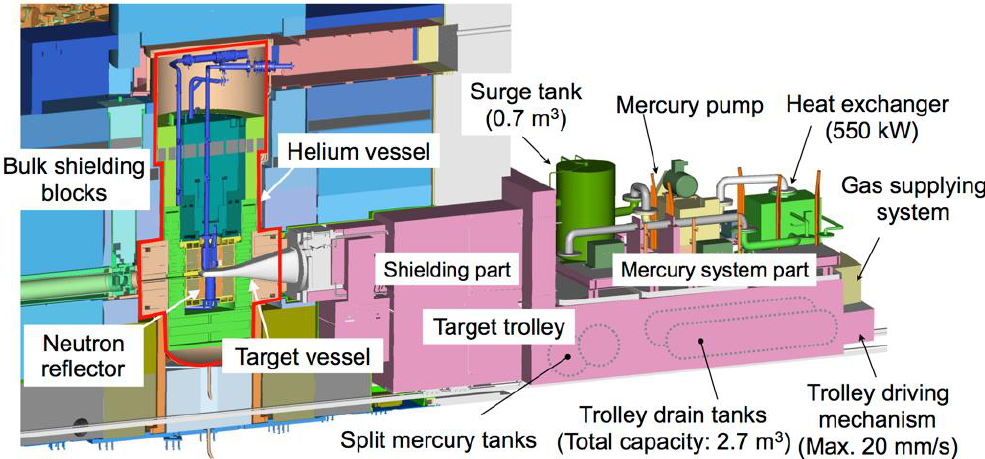
Figure 2. Layout of devices in the mercury target system mounted on the target trolley.